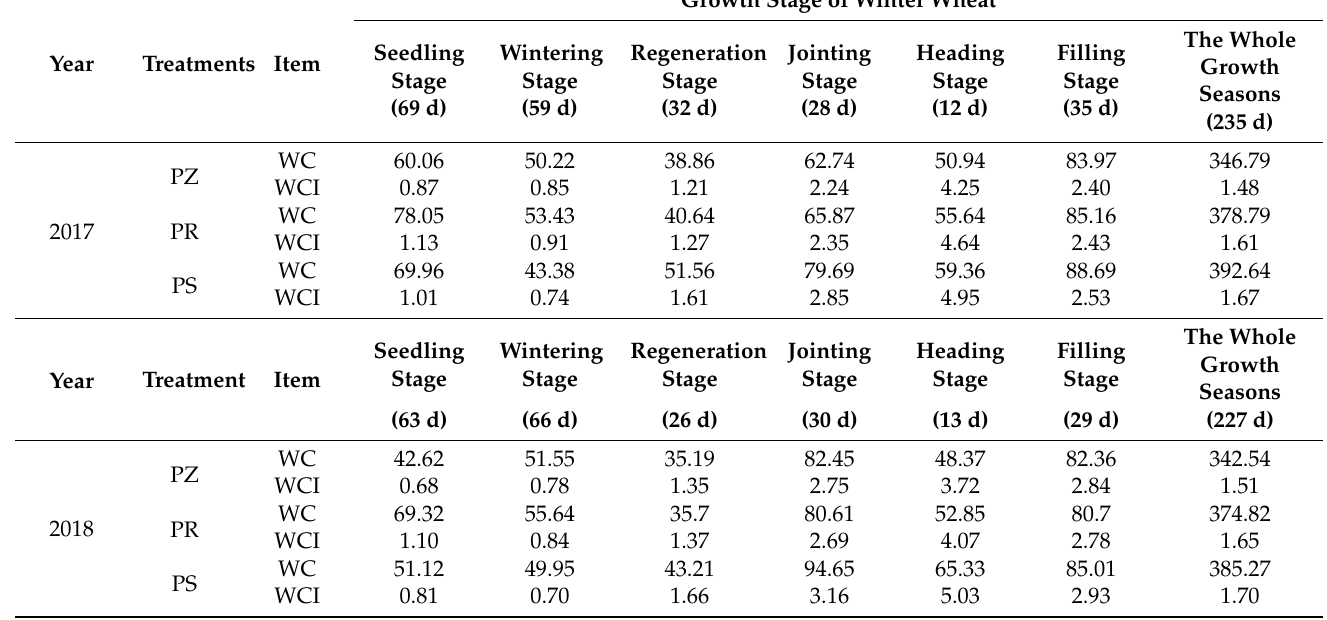
Table 6. Water consumption (mm) and intensity (mm d − 1 ) of each growing stage under different tillage